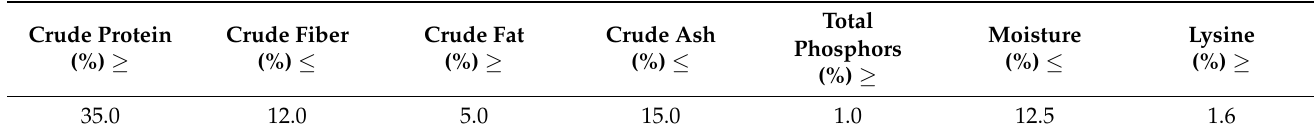
Table 1. Feed nutritional